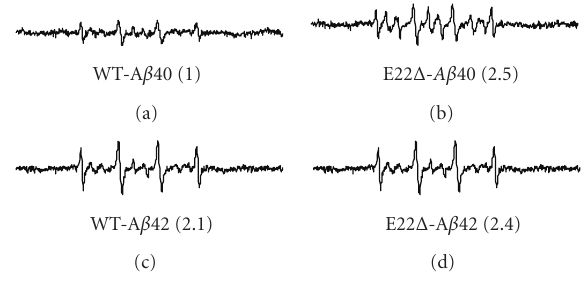
Figure 3: ESR spectra of E22 Δ -A β 40 and E22 Δ -A β 42 (100 μ M) after 48-hr incubation at 37 ◦ C. (a) A β 40, (b) E22 Δ -A β 40, (c) A β 42, (d) E22 Δ -A β 42. The spectra of A β are shown after subtraction of the background spectrum in the presence of PBN without A β . Numbers in parentheses represent relative integral intensities of ESR signals, where the intensity of A β 40 was taken as